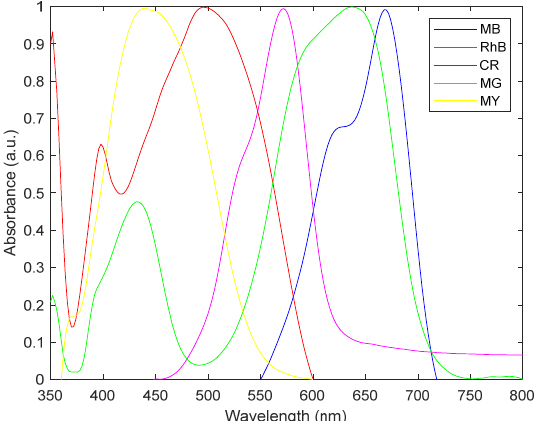
Figure 6. UV-VIS spectra of all of the dyes of this study with their maxima absorbance peaks located at different wavelength position from 425 to 670 nm.